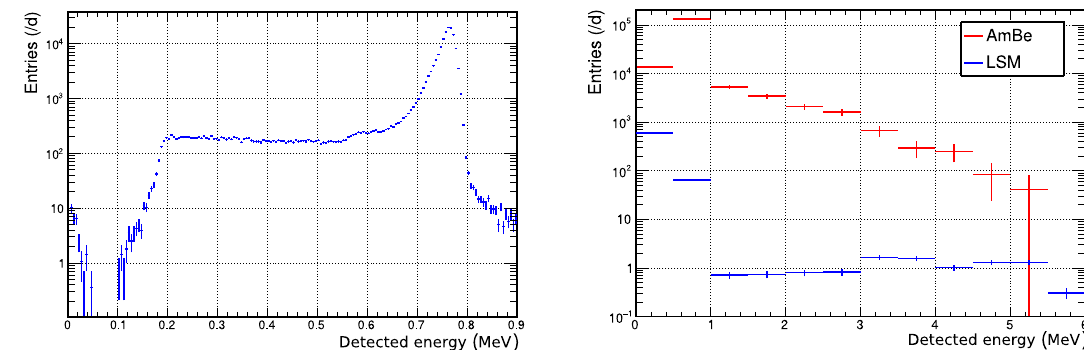
positioned at 1 m from the detector, done at the IP2I (red). Note that events appearing above 1 MeV are expected to be produced by fast neu- trons from both elastic scattering, predominantly on 3 He, and on-flight captures also on 3 He. In the case of the AmBe neutron calibration a 5 mm thick B 4 C loaded rubber was surrounding the detector in order to avoid spectral distortions arising from thermal capture pile-up